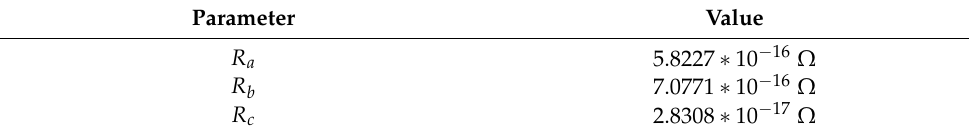
Figure 12. Capacitive resistance PD model.